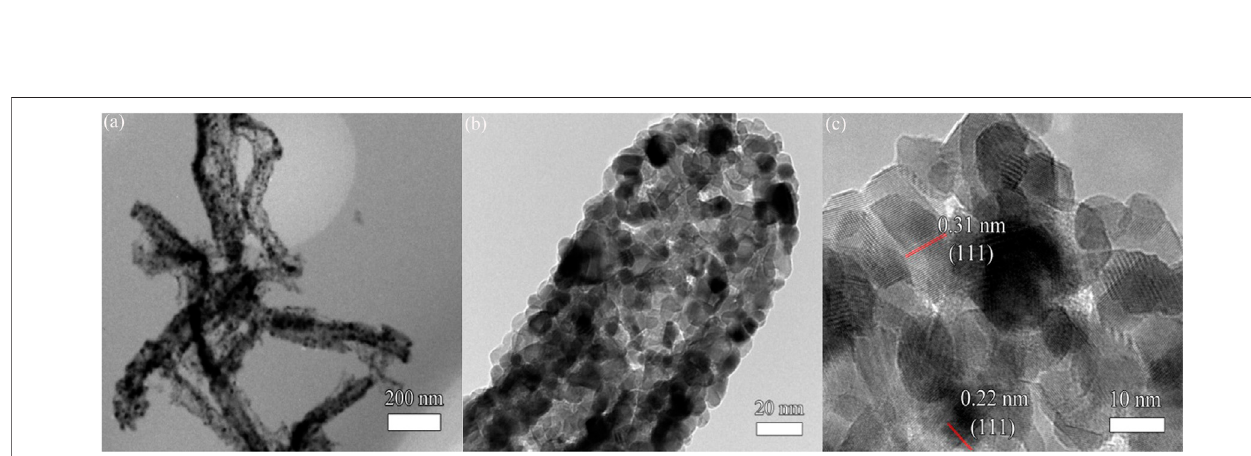
FIGURE 5 | (A) TEM image and (B) high-resolution transmission electron microscopy (HRTEM) of cerium dioxide fi ber membranes.